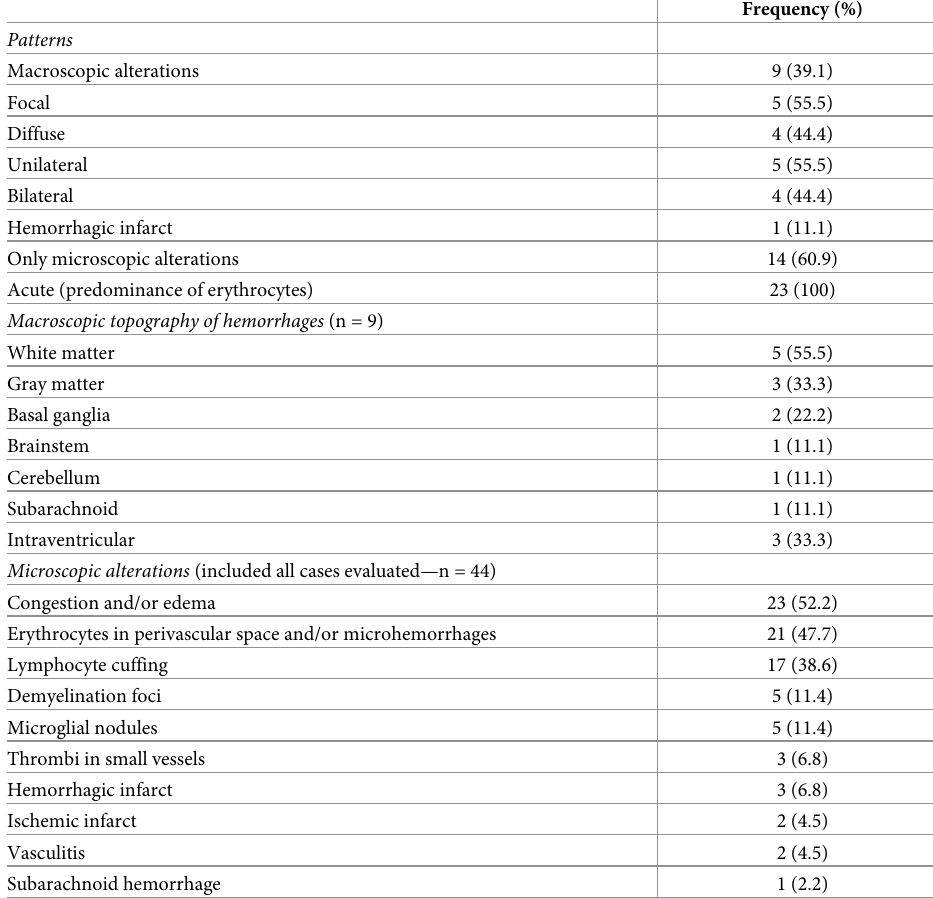
Table 5. Hemorrhagic and thrombotic manifestations: Patterns and